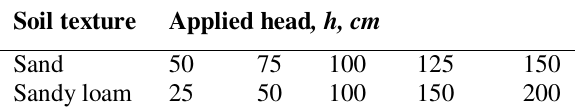
Values of applied hydraulic heads at soil